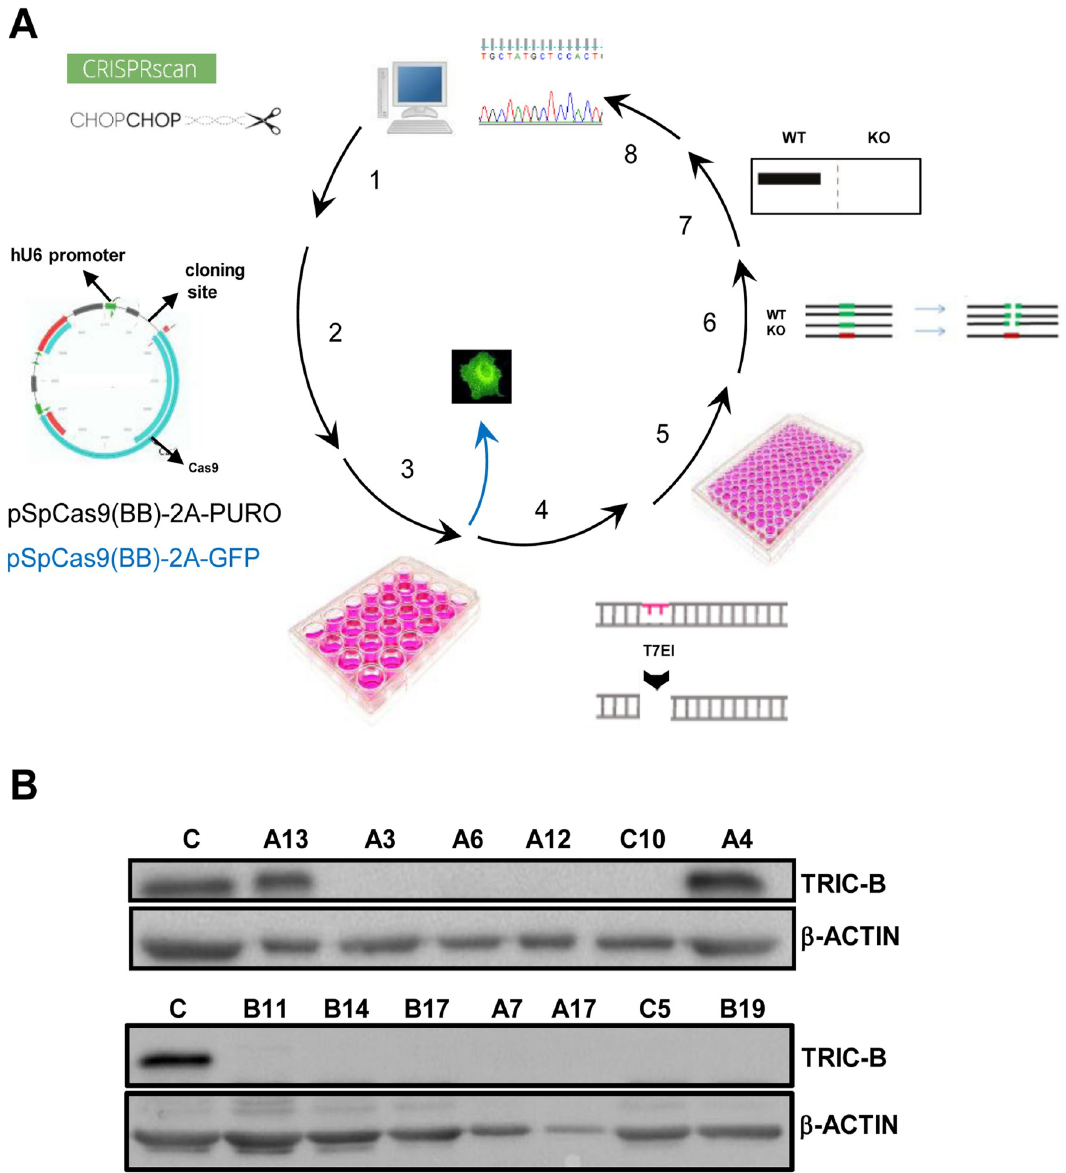
Fig 1. OI type XIV in vitro model generation and western blot validation. (A) Strategy used to generate in vitro TMEM38B models by CRISPR/Cas9 genome editing. (1) In silico target sequence identification; (2) cloning of gRNAs in the eukaryotic expressing vectors pSpCas9(BB)-2A-GFP and pSpCas9-2A-PURO; (3) hFOB cells lipofectamine transfection; (4) evaluation of targeting specificity by T7 endonuclease I assay and targeting efficiency by GFP screening (inside blue arrow); (5) generation of single cell clonal lines by serial dilutions of the cells transfected with the pSpCas9-2A-PURO constructs; (6) clonal line screening by restriction endonuclease digestion; (7) evaluation of TRIC-B protein by western blotting; (8) clones genotyping by sequencing. (B) Western blot analyses using TRIC-B specific antibody. The absence of protein expression is evident in mutant clones obtained from transfection with gRNA-2 (A3, A6, A7, A12, A17), gRNA-3.2 (B11, B14, B17, B19) and from transfection with both guides (C5, C10). Clones identified as WT (A4) or heterozygous (A13) from restriction enzyme digestion analysis expressed the protein similarly to not- transfected control cells (C). et al in human patients’ cells [14]. 3 H-proline labelled collagen type I from TRIC-B KO clones revealed a faster migration of α (I) bands respect to control supporting reduced hydroxylation and glycosylation ( Fig 2F ).